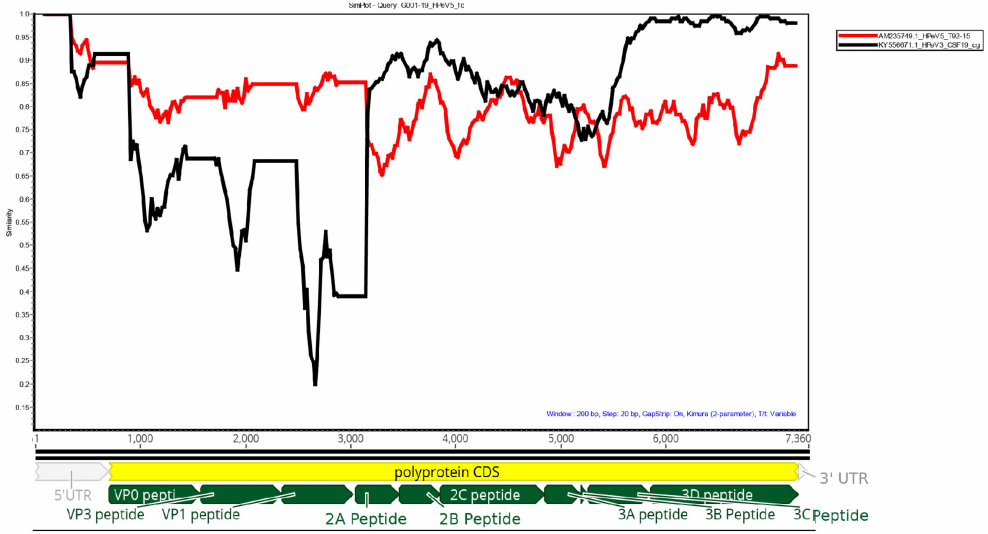
Figure 1. SimPlot analysis was used to plot the degree of similarity between the HPeV5 G001-19 sequence and those of the closest near-full length sequences of HPeV5 (AM235749 [16]) and HPeV3 (KY556671 [4]) available in NCBI. The position of the 5’UTR, viral peptides and 3’UTR are shown below the